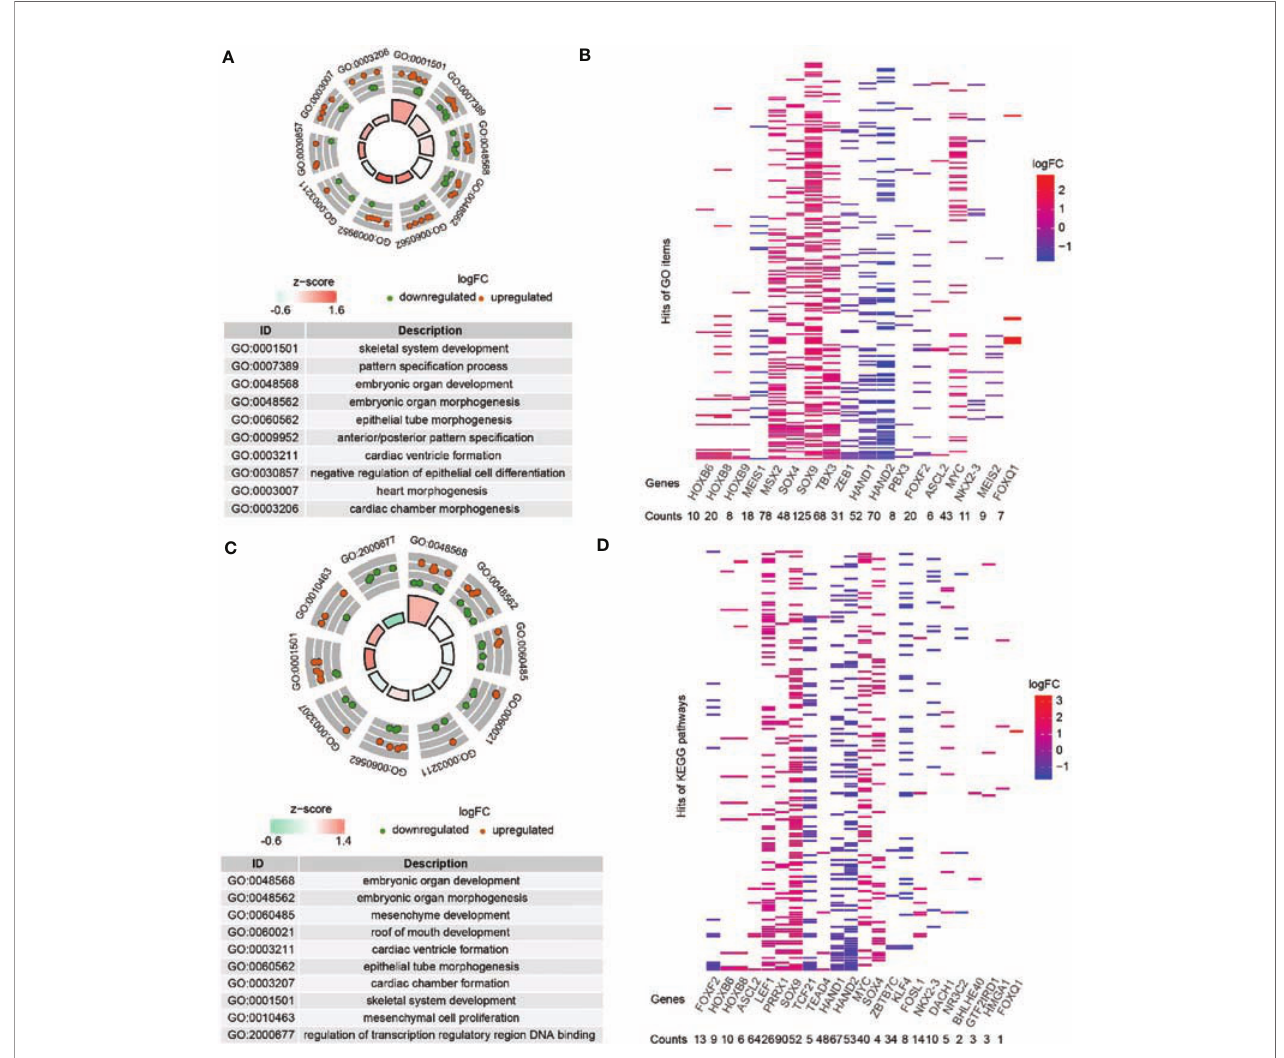
FIGURE 2 | GO-BP (Biological processes) annotation for DE-TFs. (A) Top ten enriched GO-BP terms from DE-TFs between adenoma and mucosa were shown in a GOcircle Plot. (B) All signi fi cantly enriched GO-BP terms from DE-TFs between adenoma and mucosa were displayed in the heatmap. (C) Top ten enriched GO-BP terms from DE-TFs between tumor and mucosa were shown in a GOcircle Plot. (D) All signi fi cantly enriched GO-BP terms from DE-TFs between tumor and mucosa were displayed in the